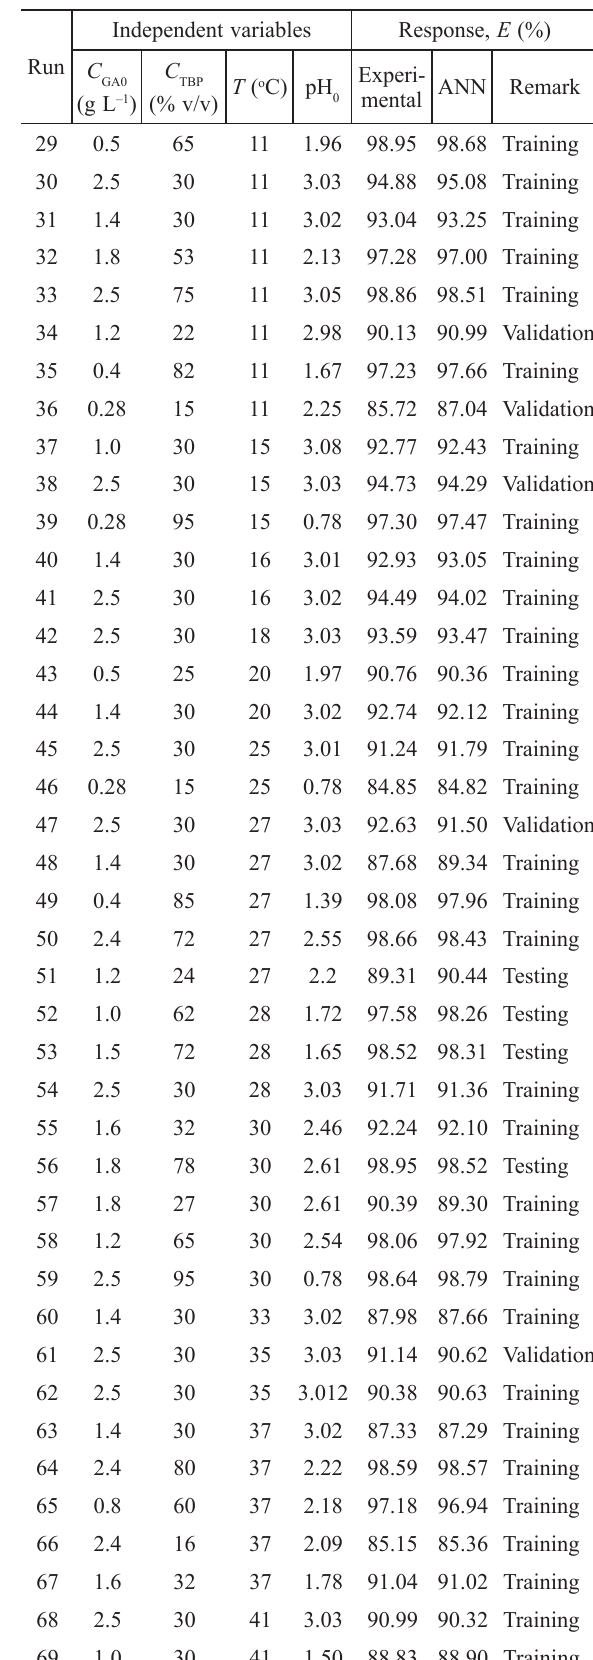
Table 4 – Additional experimental dataset used for the